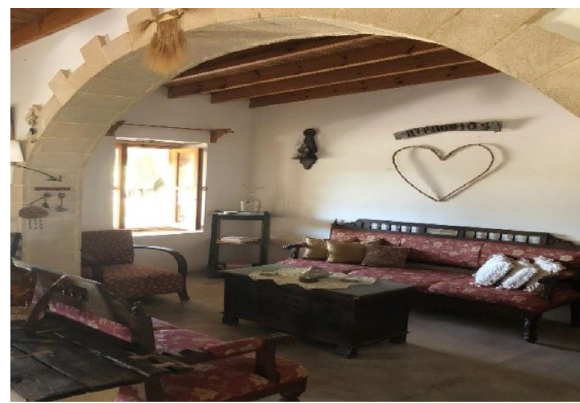
Fig. 20 Ayphodios Guest House. An example of a stone arched structure — Komikebir.